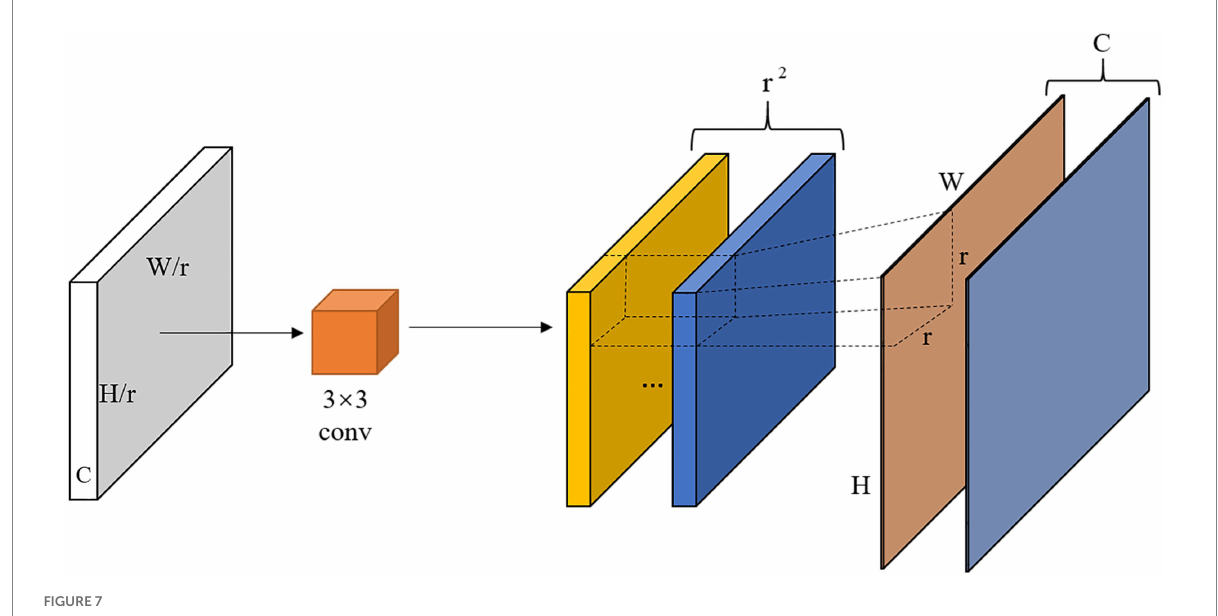
FIGURE 7 Illustration of DUC operation.